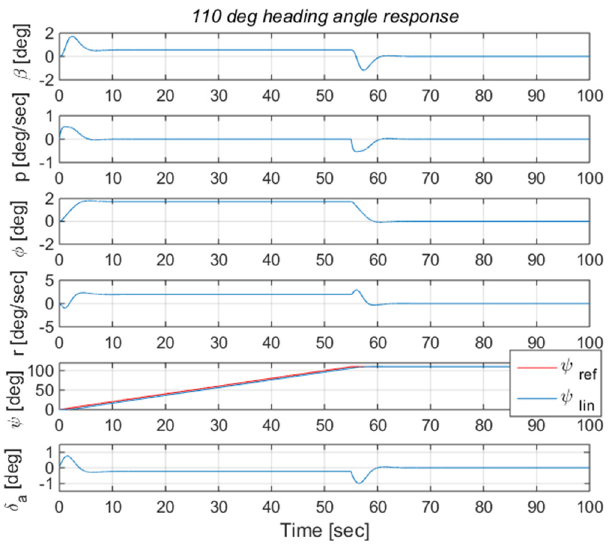
Figure 15. Heading angle control response for 110° reference.